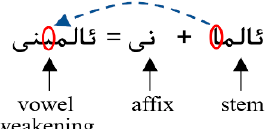
Figure 6. An example of vowel weakening.